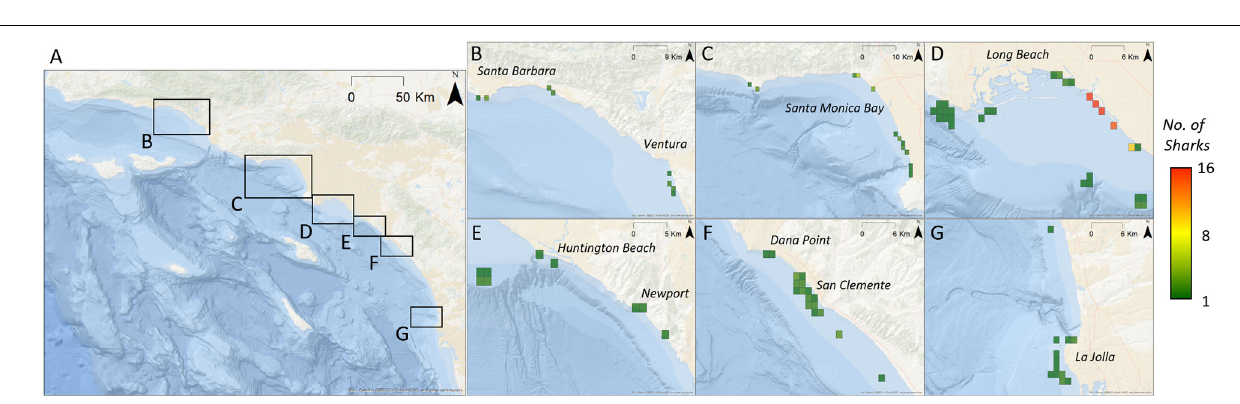
Frontiers in Marine Science |